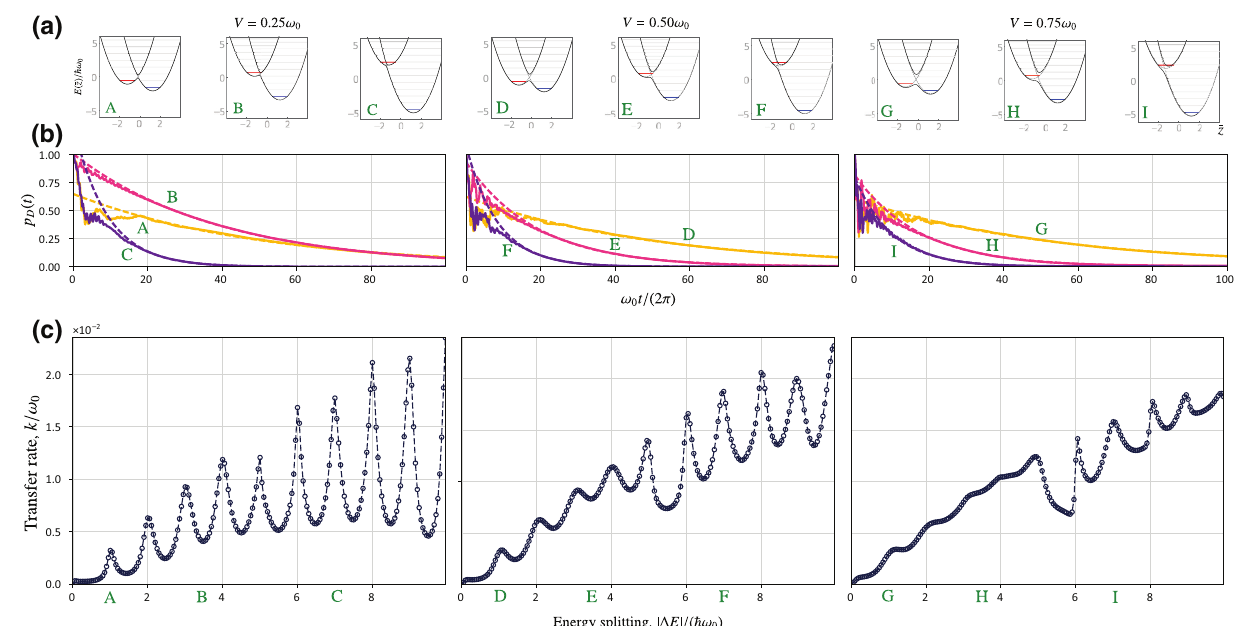
FIG. 4. The crossover toward quantum adiabatic transfer and population trapping. (a) The BO surfaces split into lower and upper adiabatic surfaces, separated by an avoided crossing of size 2 | V | . The diabatic picture is no longer adequate due to the formation of hybridized vibronic states. (b) The time evolution of the donor-state population as generated by Eqs. (1) and (3), for V = 0.25 (cid:2) ω 0 (left panels), V = 0.50 (cid:2) ω 0 (center), and V = 0.75 (cid:2) ω 0 (right). All remaining parameters are chosen as in Fig. 3. The plots show the evolution at | (cid:2) E | = (cid:2) ω 0 (A,D,G; yellow lines), | (cid:2) E | = 3.5 (cid:2) ω 0 (B,E,H; pink lines), and | (cid:2) E | = 7 (cid:2) ω 0 (C,F,I; violet lines). The corresponding dashed lines show exponential fits after a transient evolution time of ω 0 t / 2 π = 20. (c) The transfer rates extracted from the exponential fits of the simulated quantum dynamics, as a function of the donor-acceptor energy gap (cid:2) E